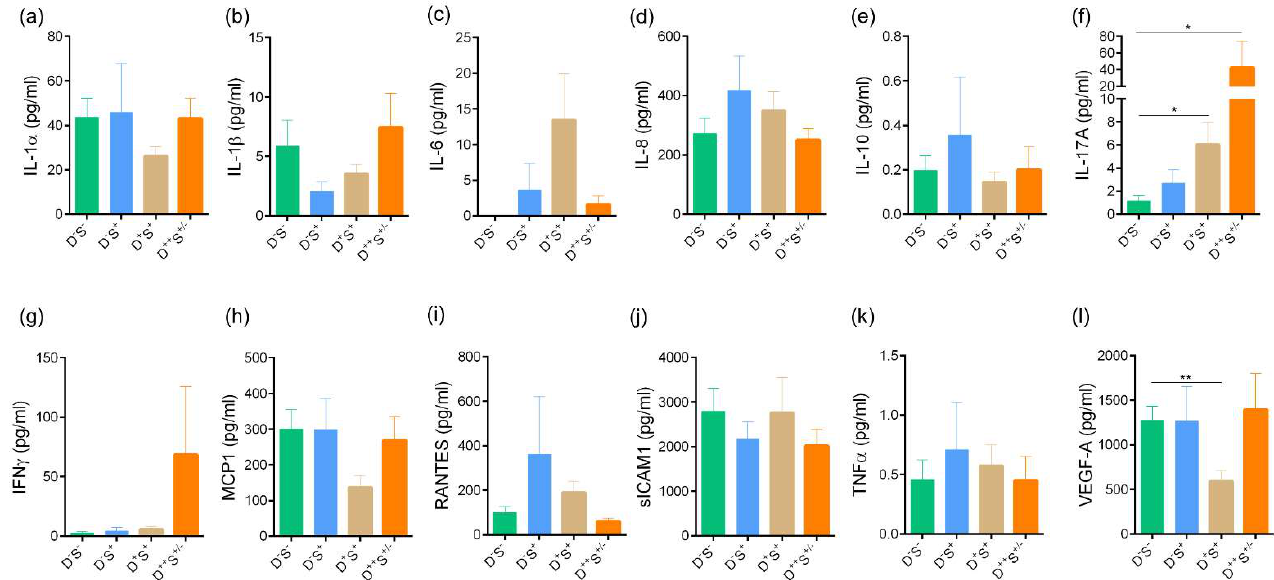
Figure 6. Tear fluid secreted factors level in subjects categorized based on discomfort concordance to signs (DCS) grouping strategy. Bar graphs represent the tear fluid levels of ( a ) IL-1α, ( b ) IL-1β, ( c ) IL-6, ( d ) IL-8, ( e ) IL-10, ( f ) IL-17A, ( g ) IFNγ, ( h ) MCP1, ( i ) RANTES, ( j ) sICAM1, ( k ) TNFα, and ( l ) VEGF-A in the study subjects grouped in the various categories based on DCS grouping strategy.